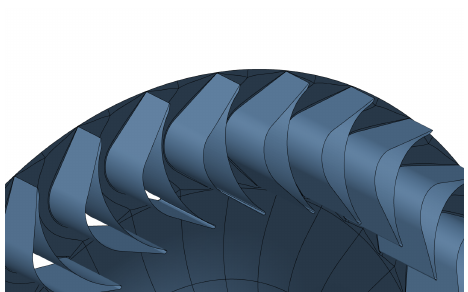
Figure 4. Stator nozzles.